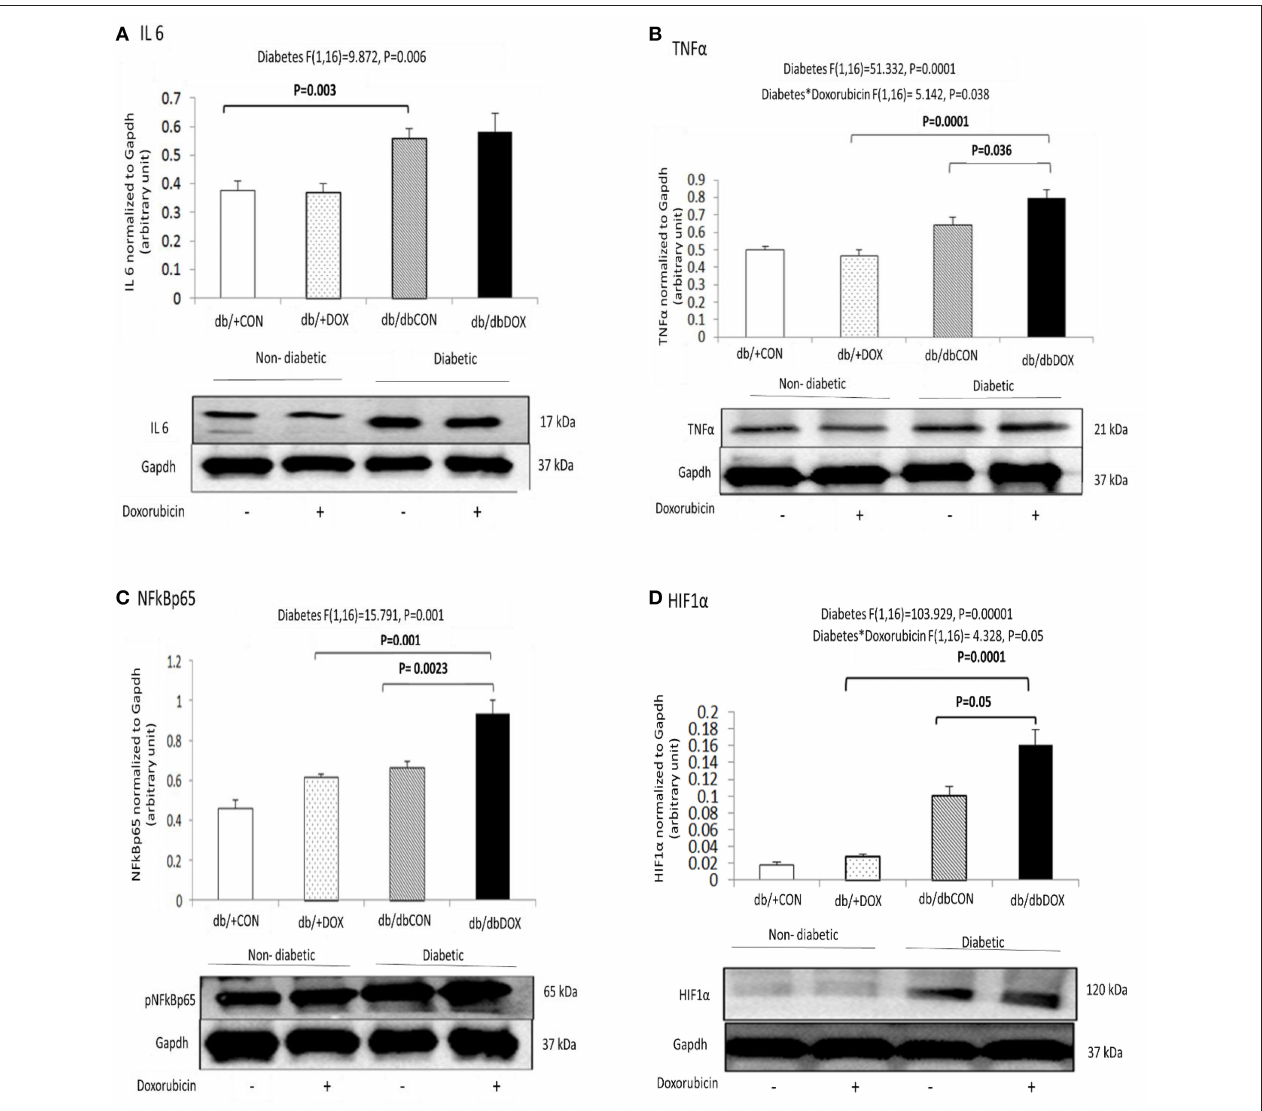
FIGURE 4 | Non-diabetic and diabetic skeletal muscle pro-inflammatory microenvironment after DOX exposure examined by phosphorylation statuses of myokines: IL6 (A) TNF α (B) pNFkBp65 (Key regulator) (C) and HIF1 α (transcription factor) (D) are shown. Data are expressed as mean ±